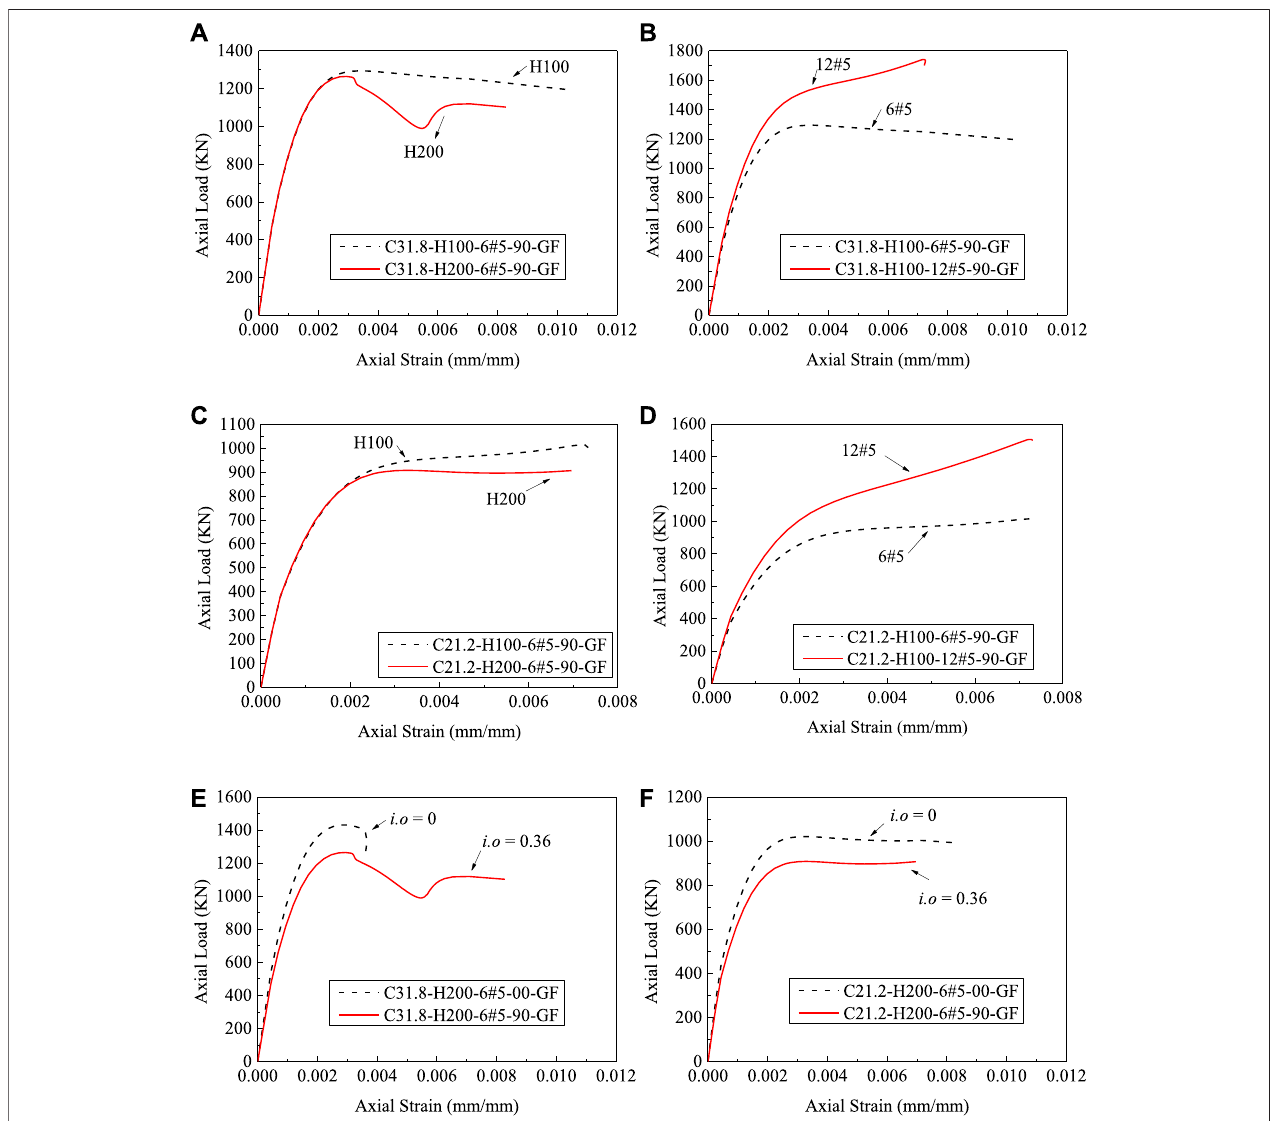
FIGURE 10 | Test parameters effects on load-strain response. (A, C) GFRP-RC HCCs with different hoop reinforcement ratios and concrete strengths; (B, D) GFRP-RC HCCs with different longitudinal reinforcement ratios and concrete strengths; (E, F) GFRP-RC columns with different inner-to-outer diameter ratios and concrete